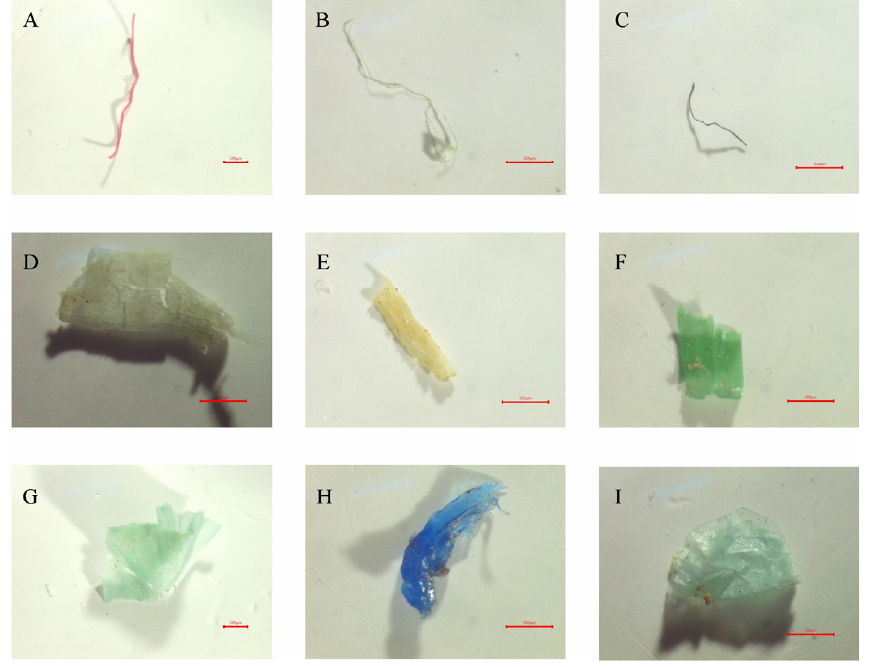
Figure 3. Micrographs of typical microplastics. ( A – C ) are fibers, ( D – F ) are fragments, ( G – I ) are film.